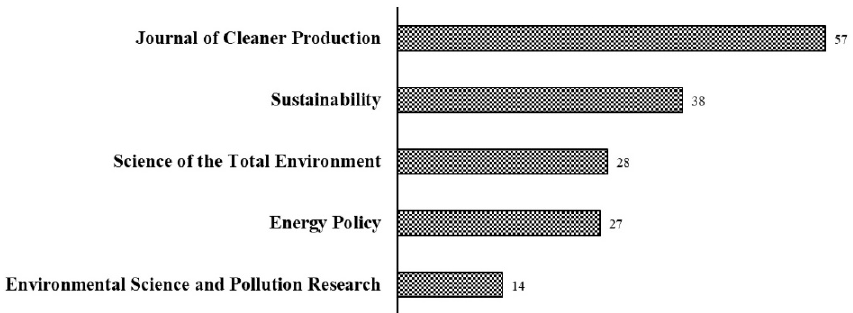
Figure 4. Top five journals by the number of publications on Web of Science.